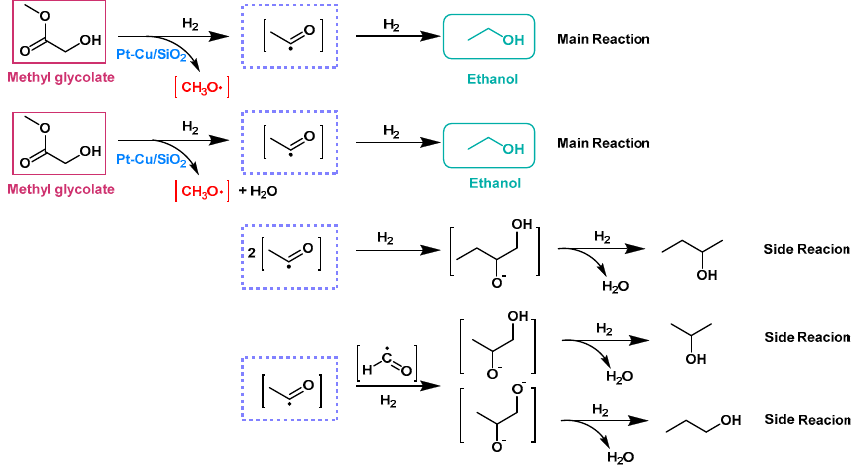
Figure 3. The proposed reaction pathways for MG hydrogenation with Pt-Cu/SiO 2 as a